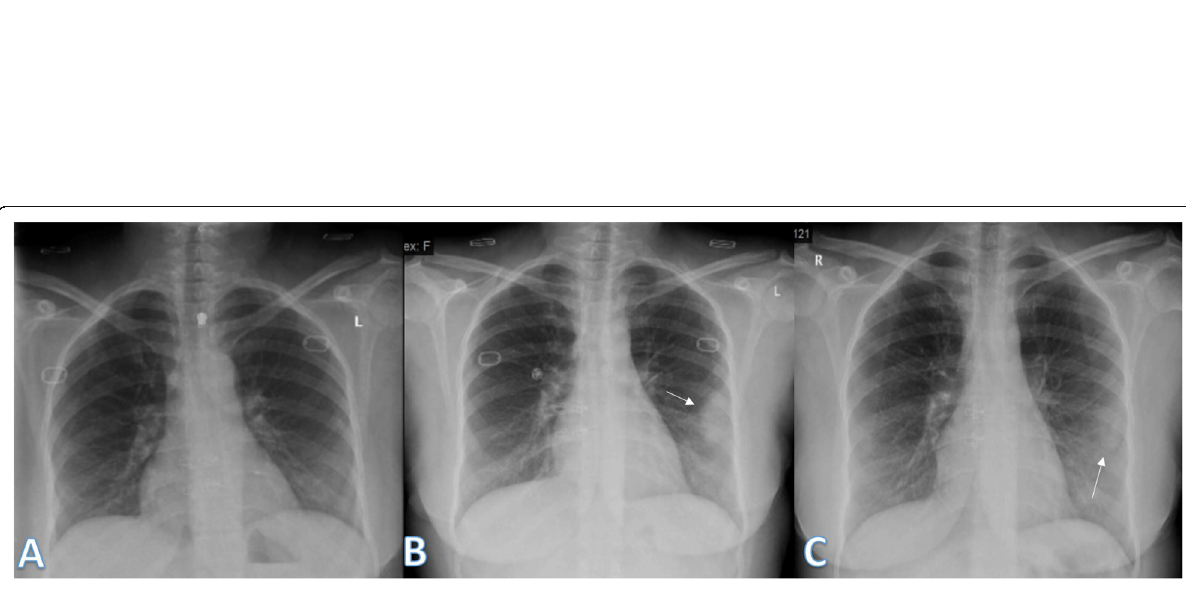
Fig. 19 41-year female with positive COVID-19 virus. Initial chest X-ray ( a ) was normal. On the 3rd day, follow-up chest X-ray ( b ) shows a well- defined large solitary pulmonary nodule (arrow) at the periphery of the left middle lung zone with TSS as 1. On the 18th day ( c ), the lesion was partially resolved with faint density